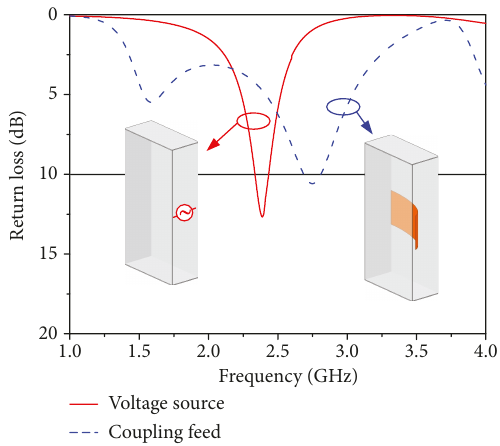
Figure 3: Return loss as the vertical slot is excited by a tapered patch compared with a voltage-source excitation.